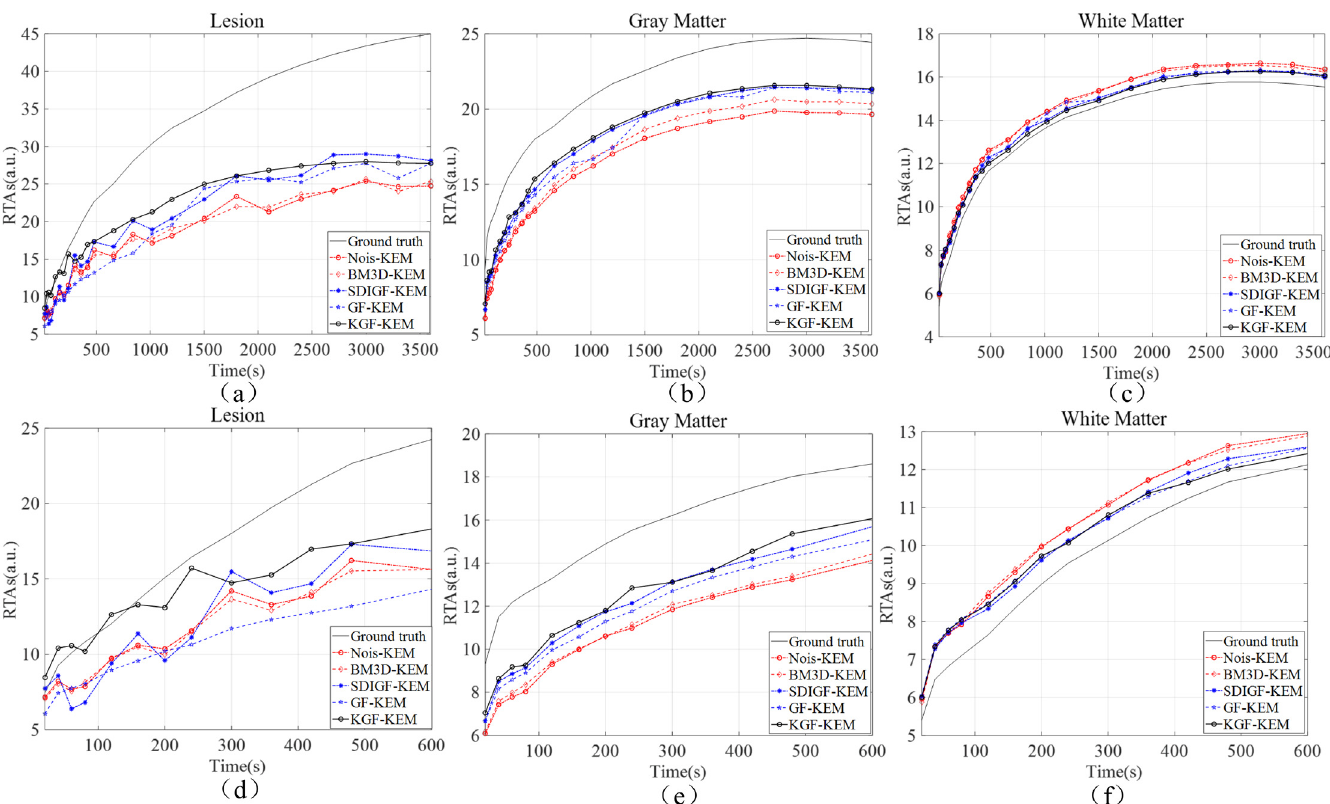
Fig 9. RTAs and local TACs of KEM reconstructed image frames from the sinograms denoised by different methods. (a) Lesion, (b) gray matter, and (c) white matter over 0–3600 seconds. (d) Lesion, (e) gray matter, and (f) white matter over 0–600 seconds.